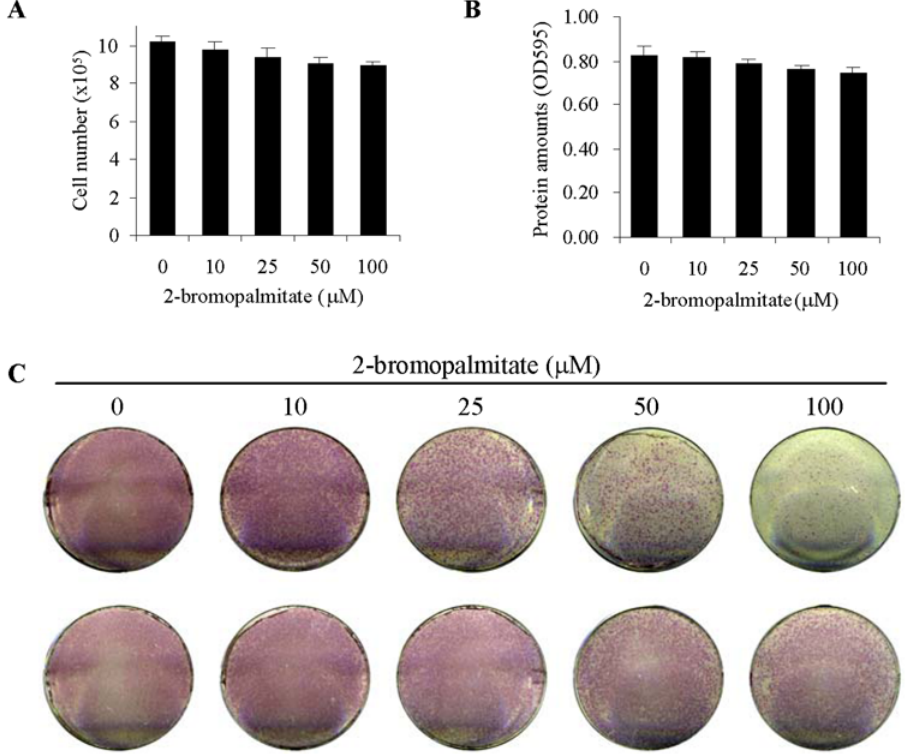
Figure 3. PAT inhibitor show minimal effect on proliferation/survival of osteoblast cultures. A. Primary osteoblast cells were cultured in differentiation medium with different amounts of 2BP for 4 days and the cell numbers in each culture plates were determined by trypan blue exclusion methods. B. The experiments were done like Fig. 3A and the cells were collected and lysed in the same volume of lysis buffer and the protein concentrations were determined by the BioRad method. C. Recovery of 2BP treated cells in ALP expression. Primary osteoblasts were treated with different concentrations of 2BP for three days, washed off, and further cultured in differentiation medium for 4 more days before being stained for ALP (bottom panel), in comparison to the cells that were treated with 2BP all the time (upper panel).